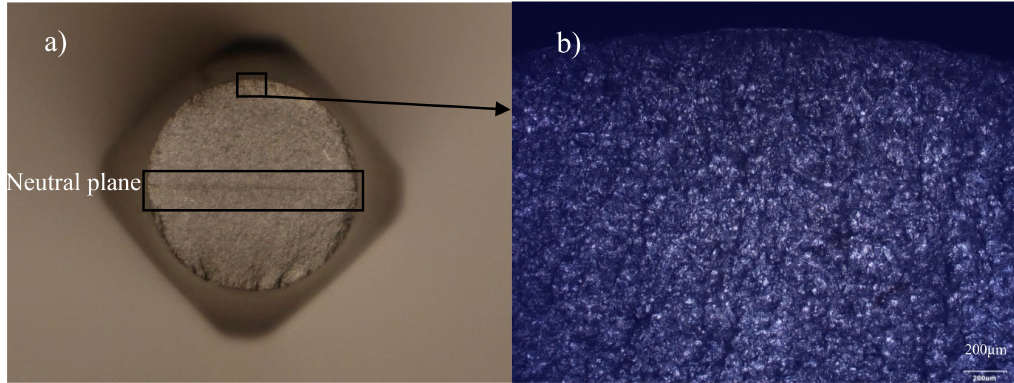
Figure 5. A cross-section with a visible neutral plane ( a ) and microscopic fracture ( b ) of the test piece after fatigue tests under oscillatory bending conditions.